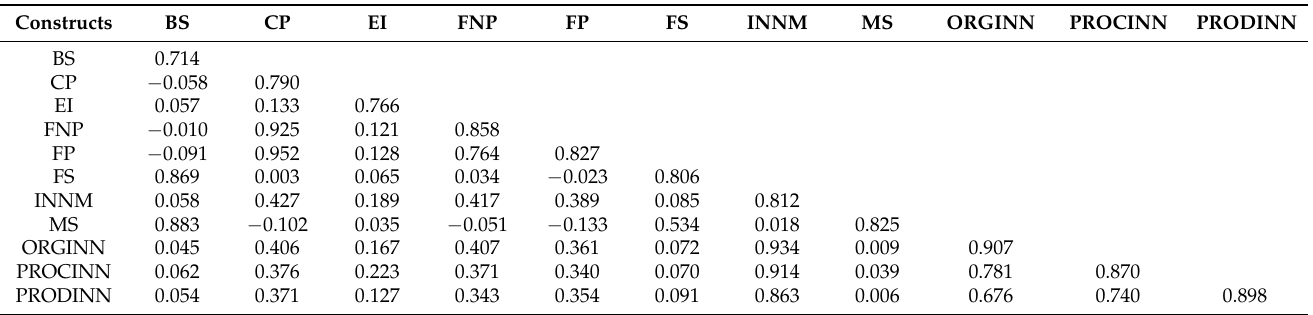
Table 2. Discriminant validity of the model: Fornell and Larcker criterion.